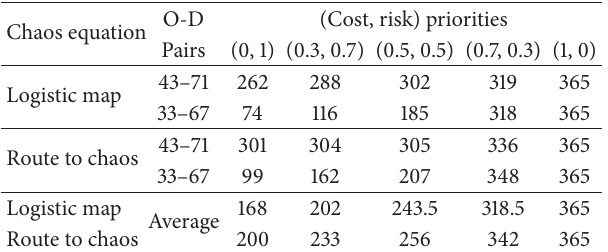
Table 3: Frequency of the best optimal paths for different chaos equations. O-D (Cost, risk) priorities Chaos equation